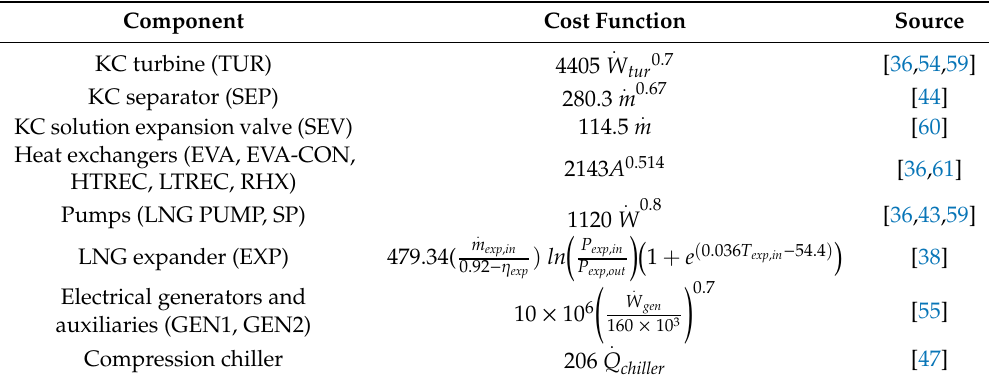
Table 8. Capital cost functions for poly-generation system components.